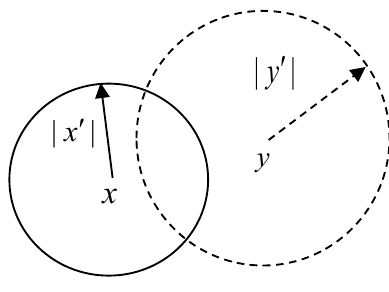
Fig.9. Embedding of subspace of nearest